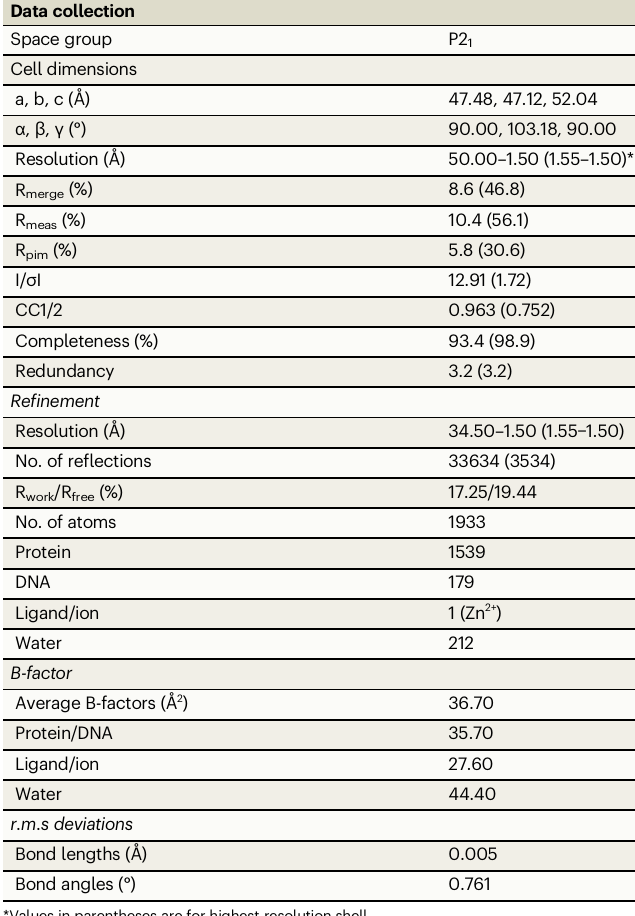
Table 3 | Data collection and re fi nement statistics